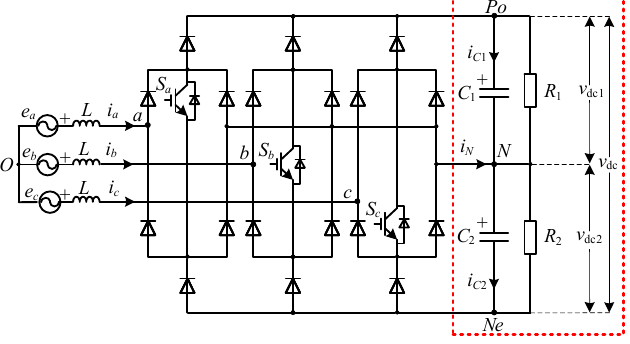
Figure 1. Topology of VIENNA